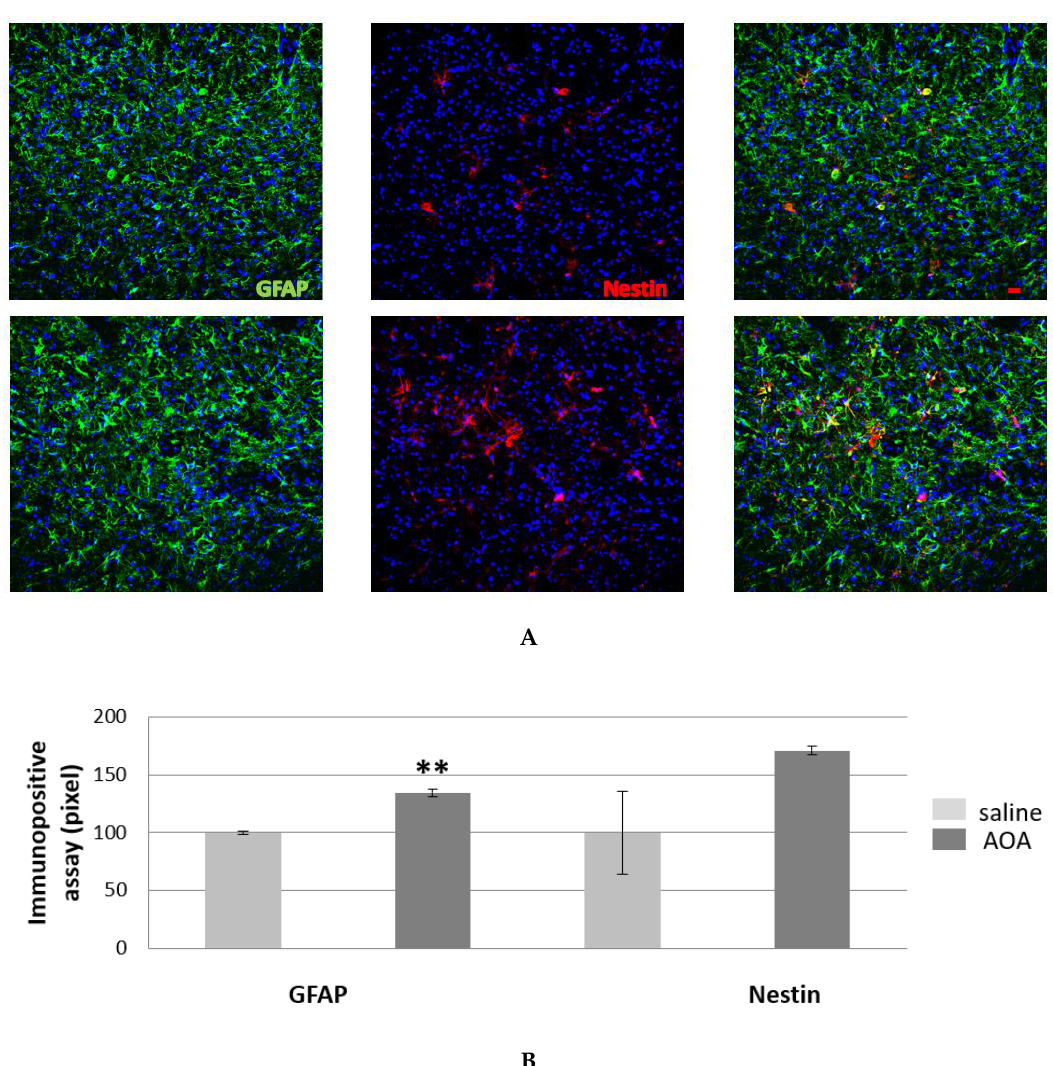
Figure 3. GFAP and nestin positive cells in the spinal cord of SOD1G93A saline- and AOA-treated mice. The double immunofluorescence of GFAP and nestin reveals an astrocyte increase in AOA-treated mice (bottom panel, ( A ) compared to those treated with saline (upper panel, A), also showed from immunopositive assay ( B ). The mean of the pixels was quantified in three fields of the ventral horn spinal cord in AOA-treated mice ( n = 3) and saline-treated mice ( n = 3), data are presented as a percentage of normalised to saline values as the mean ± SEM. The values were compared by using Student’s t -test with ** p < 0.01 (B). Scale bar = 20